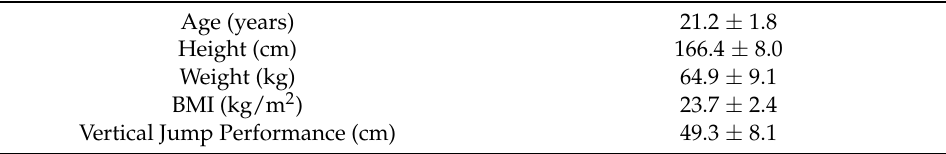
Table 1. Participant characteristics ( n =